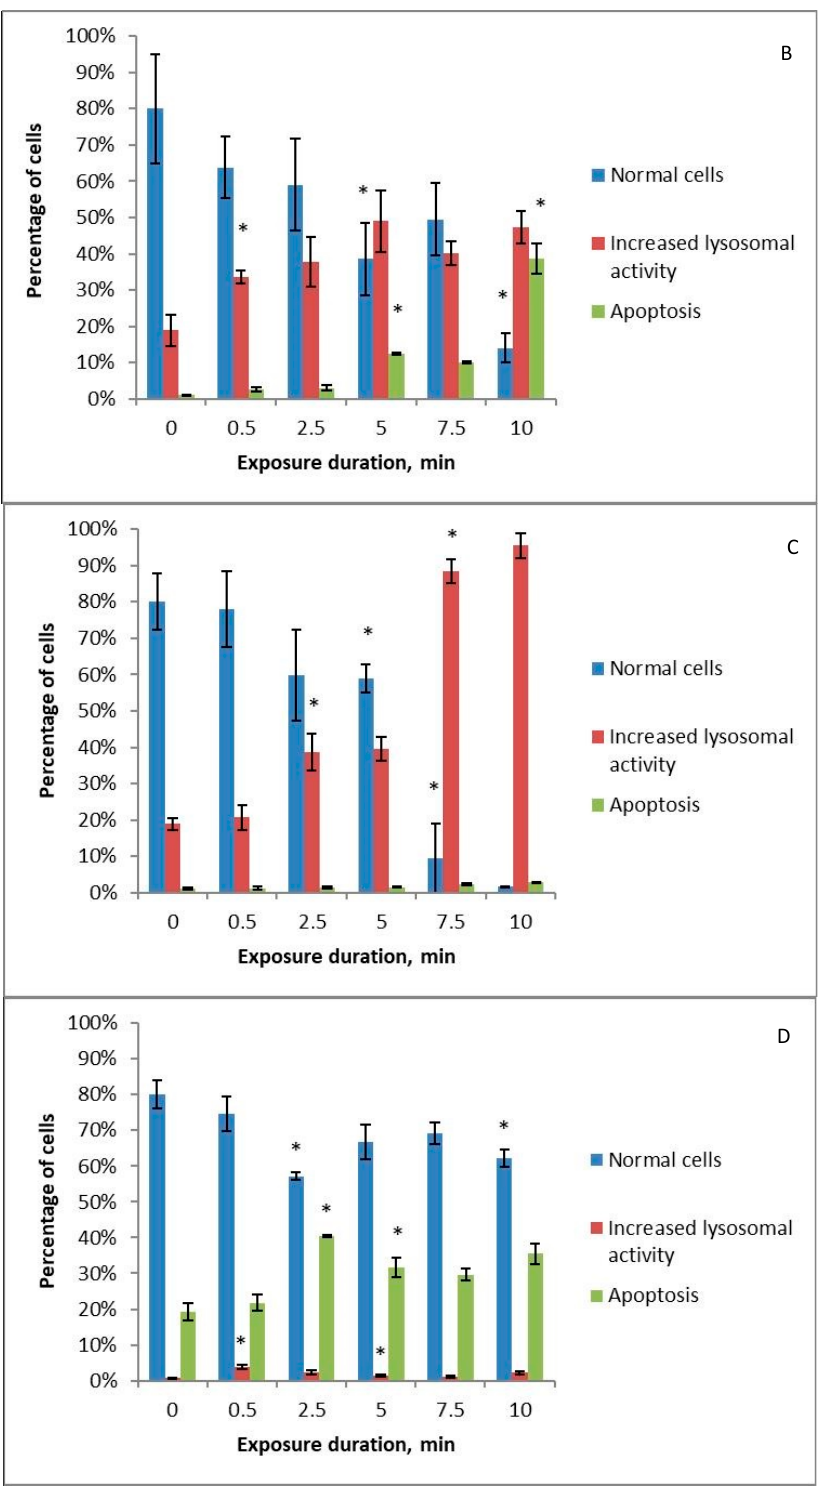
Figure 4. Changes in the apoptotic and increased lysosomal activity of K562 myeloid leukaemia cells under the influence of 0.9% NaCl solution ( A ), Ringer’s solution ( B ), and Hank’s Balanced Salt Solution ( C ) or Hank’s Balanced Salt Solution with the addition of amino acids in physiological concentrations ( D ) treated with piezoelectric direct discharge for a specific period of time without pharmaceuticals to the nutrient medium. The * sign indicates a statistically significant difference from a shorter treatment time ( p <